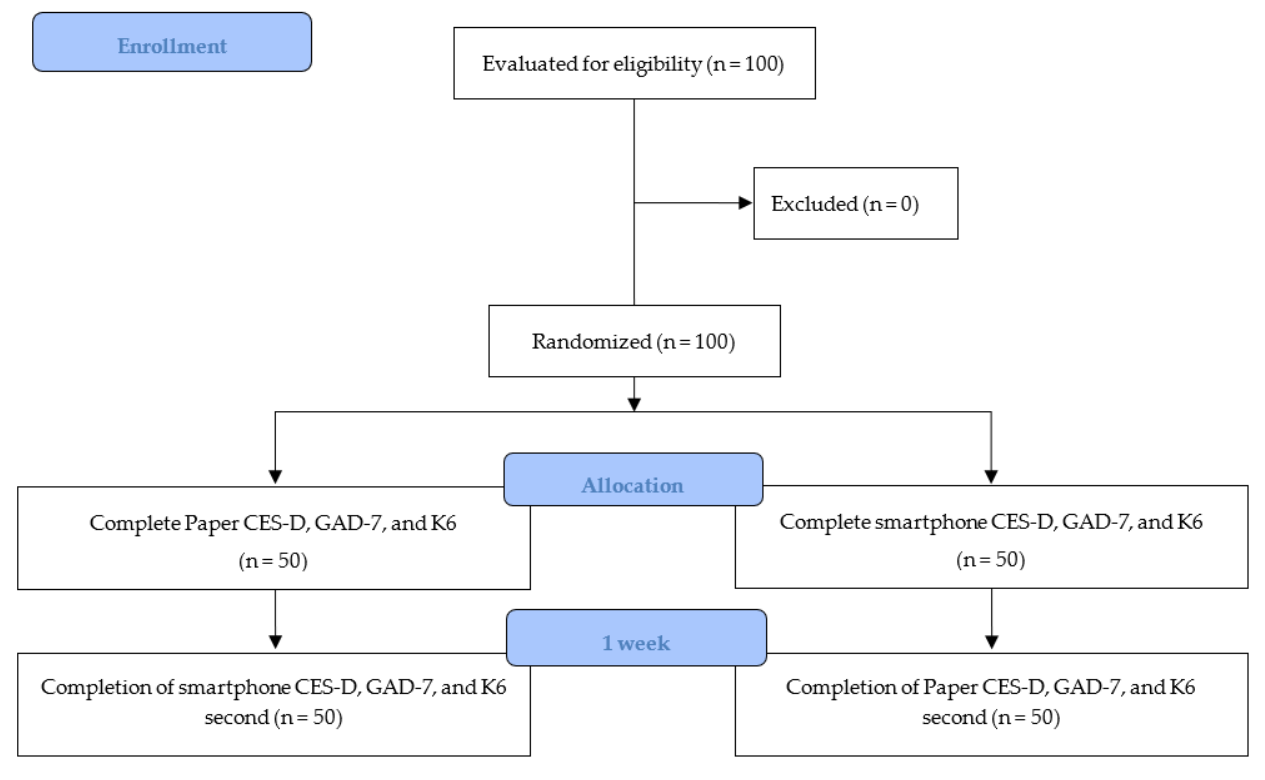
Figure 1. Flowchart of trial.